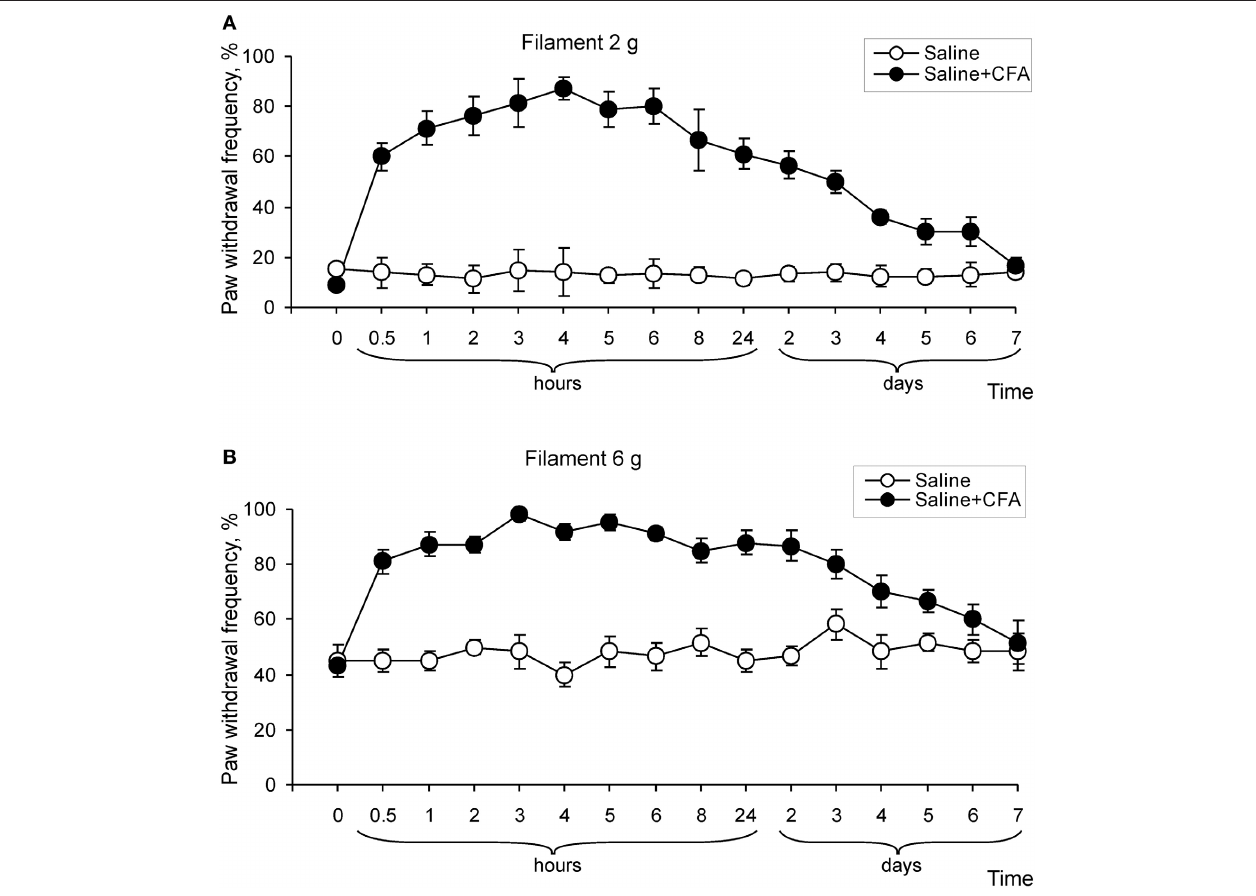
FIGURE 2 | Development of mechanical hypersensitivity after CFA injection. (A,B) Paw withdrawal frequency in response to 2g (A) and 6g (B) von Frey filaments changed over time on the ipsilateral side after CFA, but not after saline injection into a hind paw ( n > 6/time point for saline and CFA).